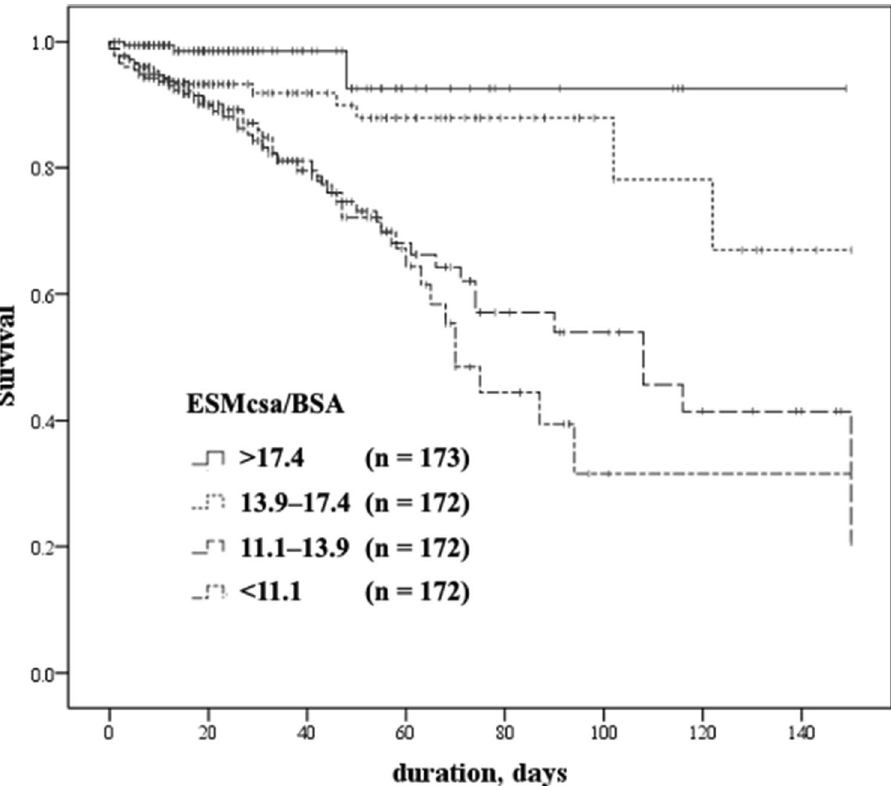
Figure 2. Kaplan–Meier curves stratified by the cross-sectional area of the erector spinae muscle (ESMcsa) adjusted by the body surface area (BSA). The cutoff values correspond to 75, 50, 25 percentile values (17.4, 13.9 and 11.1, respectively). Elderly patients with pneumonia with lower ESMcsa/BSA values exhibited significantly worse survival rates (p < 0.00; log-rank